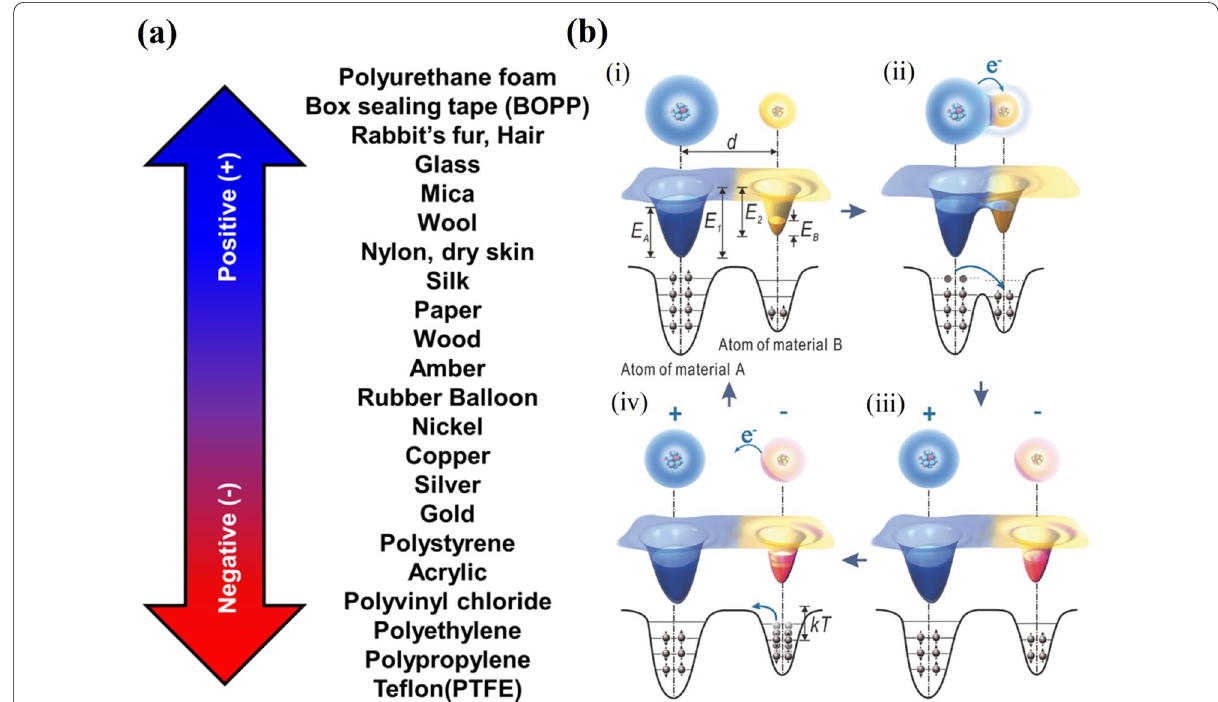
Fig. 1 a Schematic of triboelectric materials in series depending on their relative triboelectric charge attracting/receiving characteristics (Reproduced with permission from Ref [19].). b The atomic-scale-electron-cloud-potential-well model to describe the contact electrification process of a TENG (Reproduced with permission from Ref [21].)